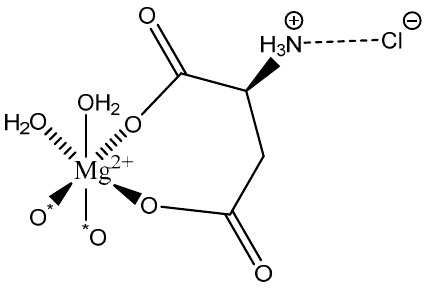
Figure 20. Illustrated structure of the Mg( L -Asp)Cl·3H 2 O reported by Schmidbaur et al. [65]. The structure is devoid of interstitial water that deems the overall complex formation a